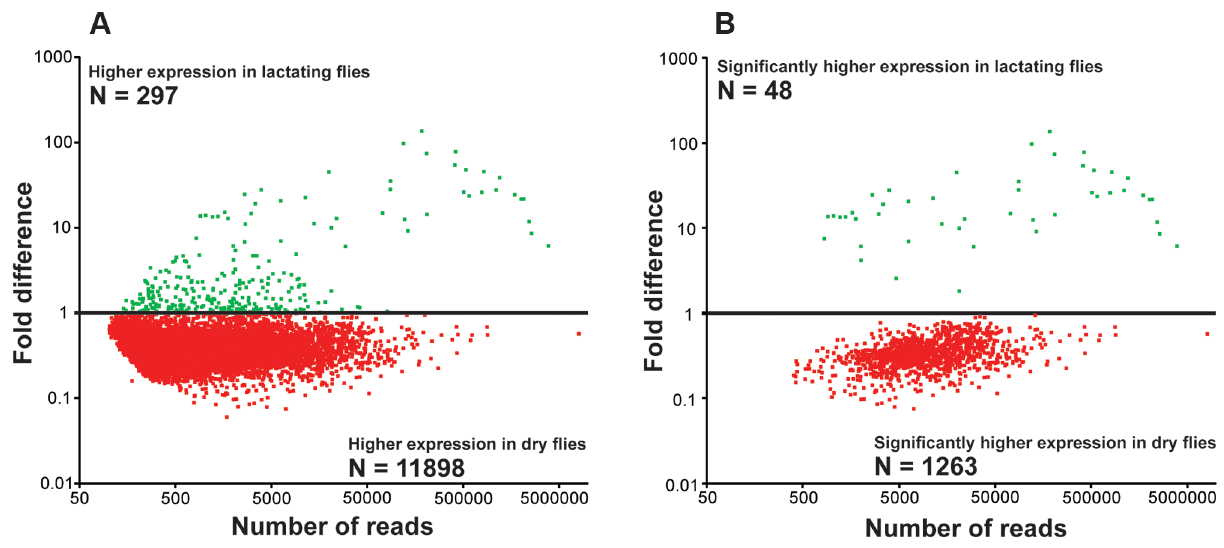
Figure 1. Fold changes in transcript expression for contigs based on RNA-seq analysis. Green indicates expression higher in lactating flies and red indicates higher expression in dry flies. (A) Relative expression of each contig with at least 50 mapped reads. (B) Contigs with significantly different expression values from A (Kal’s test with Bonferroni correction, P , 0.05).